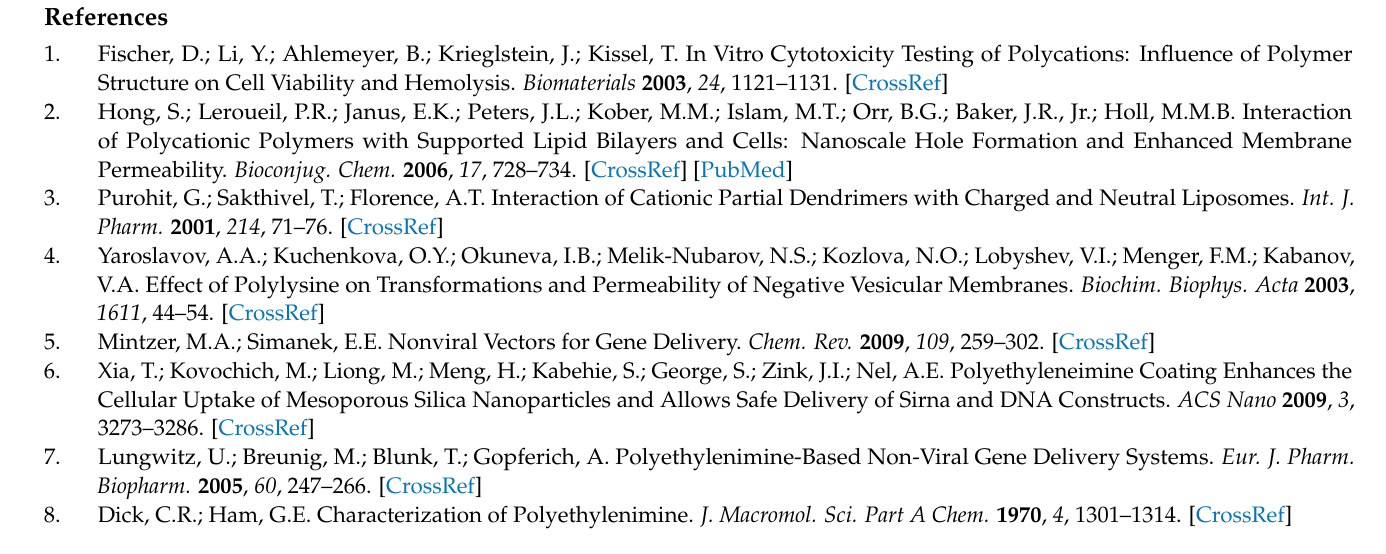
coated PC membrane, Figure S2: Distribution of Young’s modulus obtained for each bacteria using Hertz fit, Figure S3: AFM topography images and Young’s modulus of E. coli ~120 mins after immobilization, Figure S4: Topography images of E. coli pre-treated with 4 µ g/mL PEI before surface immobilization, Figure S5: Topography images of E. coli pre-treated with 100 µ g/mL PEI before surface immobilization, Figure S6: Surface topography, and corresponding Young’s modulus map as well as the normalize histogram of the Young’s modulus values of both PC and PC-PEI membranes, Figure S7: SYTO9/PI staining of E. coli before and after 15 min exposure to 4 µ g/mL and 100 µ g/mL unbound PEI, Figure S8: Effect of PEI on the pre-immobilized E. coli , Figure S9: Gompertz fitting of the growth curves (and growth parameters), Figure S10: Topography images of E. coli pre-treated with 4 µ g/mL PDNP-PEI before surface immobilization, Figure S11: Areas within the bacteria chosen for Young’s Modulus determination, Figure S12: Topography images of E. coli pre-treated with 100 µ g/mL PDNP-PEI before surface immobilization, Figure S13: Topography image of E. coli with its corresponding elasticity map, Figure S14: Young’s modulus and surface topography of PEI-coated nanoparticles (PDNP-PEI), Figure S15: SYTO9/PI staining of E. coli before and after 15 min exposure to 4 µ g/mL and 100 µ g/mL PDNP-PEI, and Figure S16: Growth of PDNP-PEI treated E. coli in M9 minimal